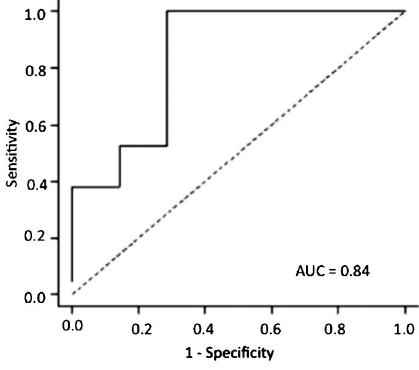
Figure 2. Receiver operating characteristic (ROC) curve at 120